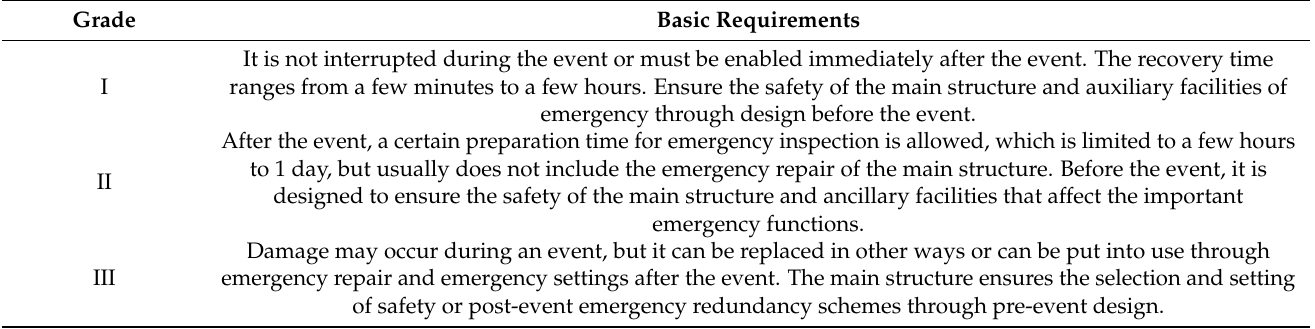
Table 2. Emergency function guarantees grade requirements of road network